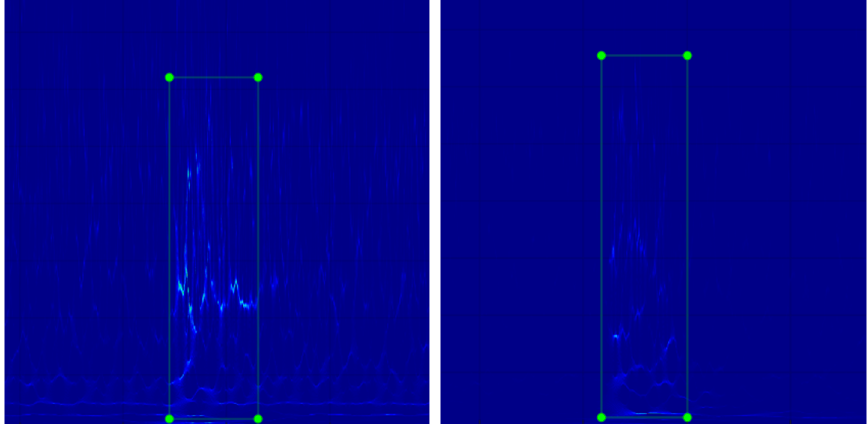
Figure 9. Wire break spectrogram dataset.